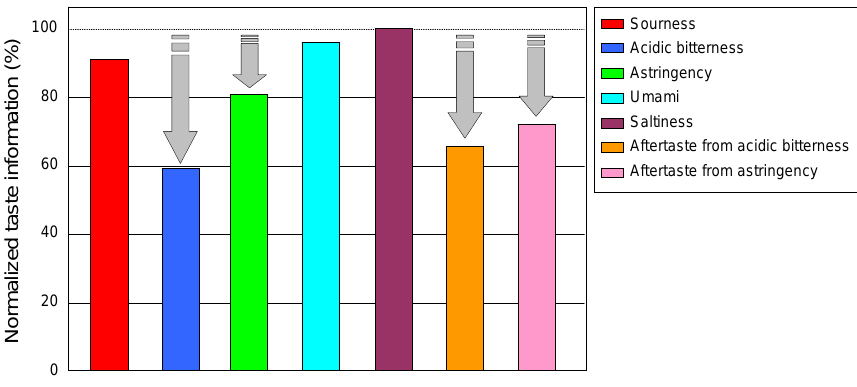
Figure 21. Suppression effect of taste qualities by edible oil (Adapted from